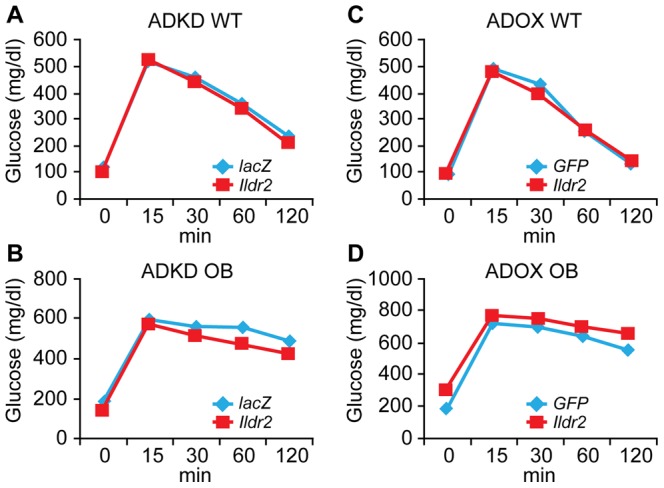
ipGTT in WT and OB mice 7 days p.t.At 7 days p.t. with adenovirus knockdown vectors expressing RNAi for lacZ or Ildr2 (left) or with adenovirus vectors over-expressing GFP or Ildr2 (right), the 10-week-old chow-fed male B6 mice that were used in the 10 day experiments were injected intraperitoneally after 12 hr fast with 2g/kg glucose. The mice used in this experiment are the same mice that on which indirect calorimetry was conducted on day 5 p.t. (A) WT ADKD; (B) OB ADKD; (C) WT ADOX; (D) OB ADOX. In both ADKD and ADOX animals, IPGTT was unaffected.